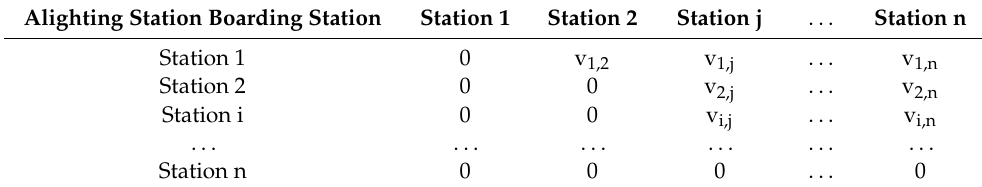
Table 1. The distribution of passenger flows for a HSR. Alighting Station Boarding